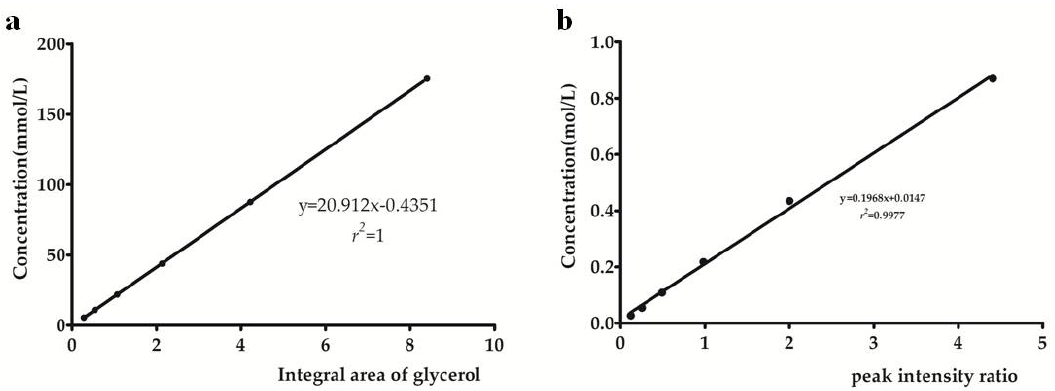
Figure 5. The plots of calibration curves for glycerol quantification ( a ) by 1 H NMR method and ( b ) by 13 C NMR method.